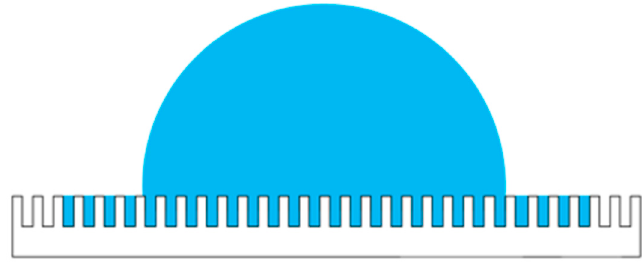
Figure 1. Droplet on microstructures according to the Wenzel model.